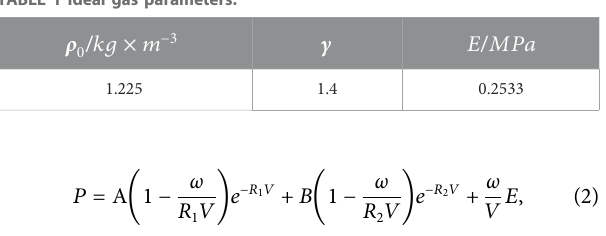
TABLE 1 Ideal gas